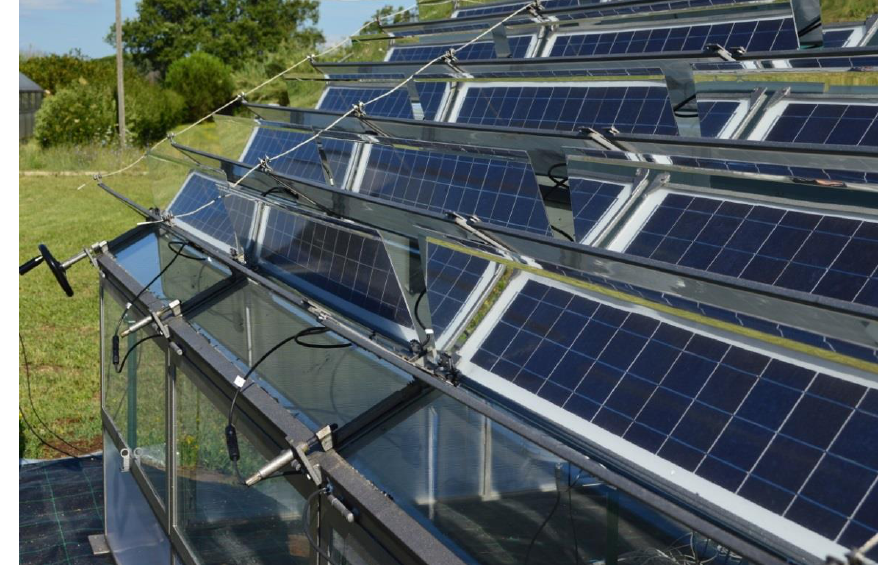
Figure 6. PV panels and mirrors on the prototype.